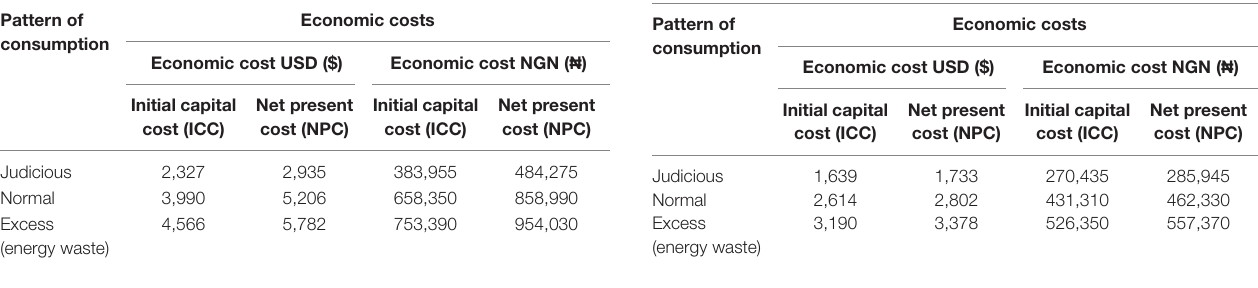
TaBle 4 | simulation results of economic costs (PV configuration with surrette